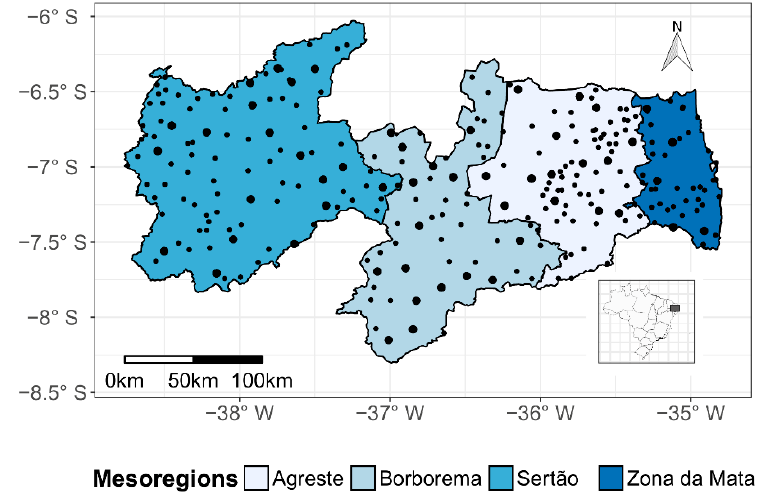
Figure 2. Spatial distribution of 269 rainfall stations sampled (black dots) in the State of Paraíba, divided into four mesoregions. The larger points are the 54 rainfall stations used to adjust the trend and the variogram.